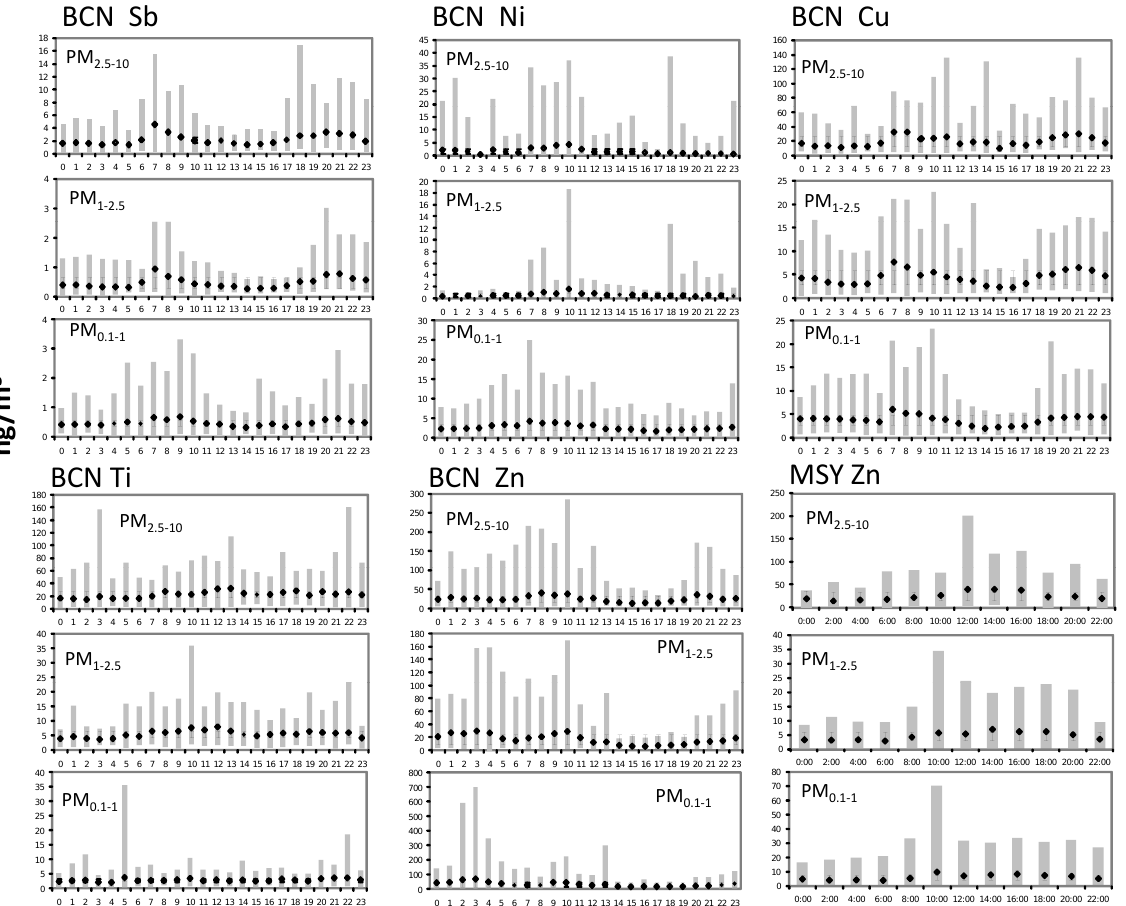
Fig. 5. Average (black rhombus) and range of hourly concentrations (horizontal axe) obtained for each PM fraction of specific metals (see Fig. 6) using